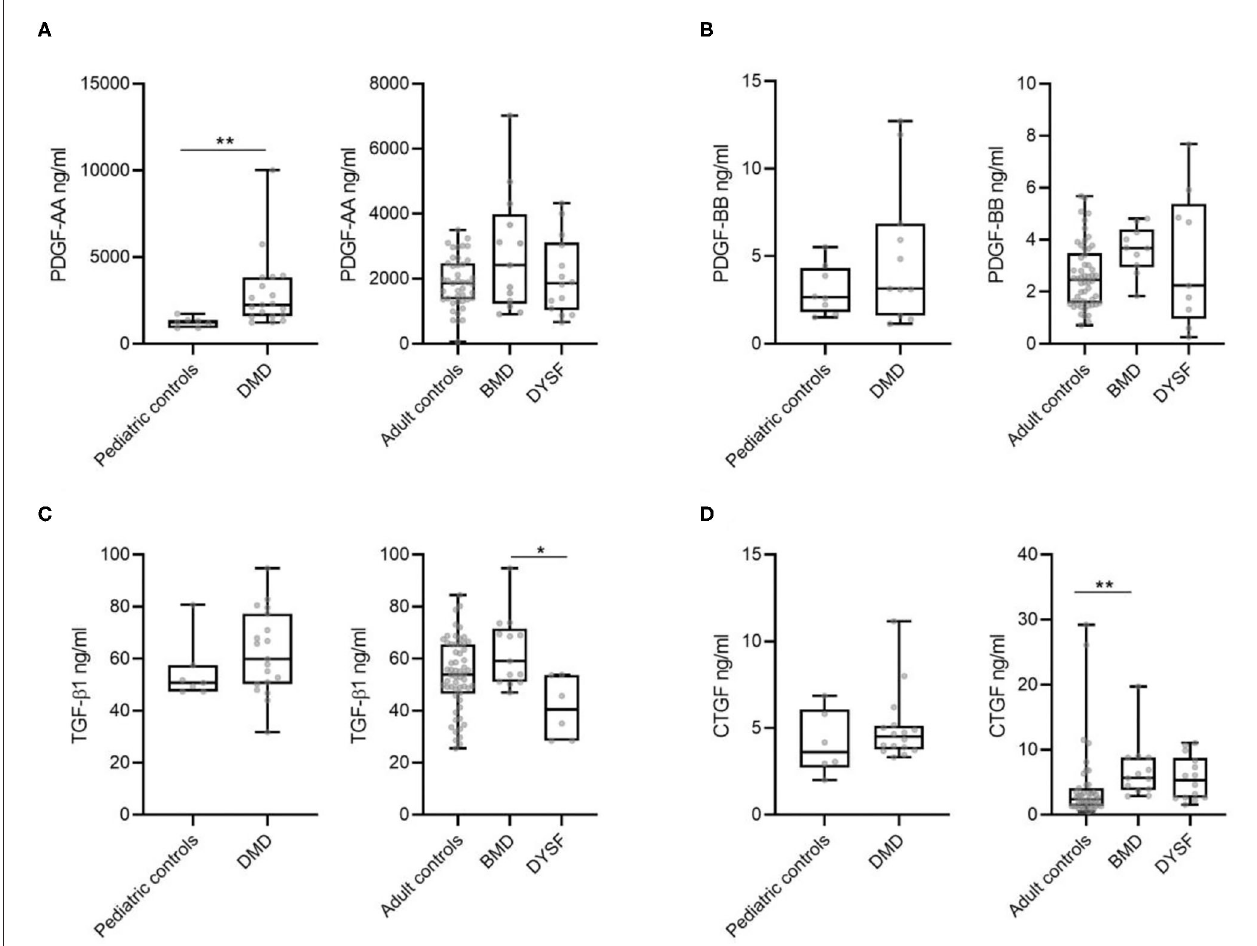
FIGURE 1 | Serum levels of different growth factors in DMD, BMD, DYSF and in pediatric and adult healthy controls. (A) PDGF-AA, (B) PDGF-BB, (C) TGF- β 1, and (D) CTGF levels were measured. Variables are represented as median and interquartile range (IQR). Statistical significance of the results by Mann-Whitney test for the DMD compared against pediatric controls and Kruskal-Wallis test/Dunn’s multiple comparison analysis for the BMD, DYSF, and adult controls: * p ≤ 0.05 and ** p ≤ 0.01.